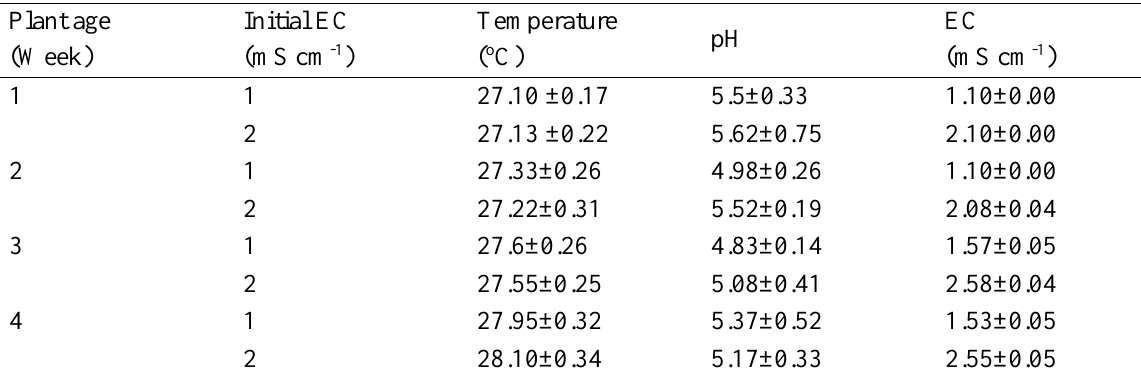
Figure 2 Number of leaves on 2 subspecies Brassica during plant growth. Values followed by the same letter in the same age are not significantly different (p < 0.05) by Duncan's multiple range test at Table 6. Temperature, pH and electrical conductivity condition based on the initial electrical conductivity